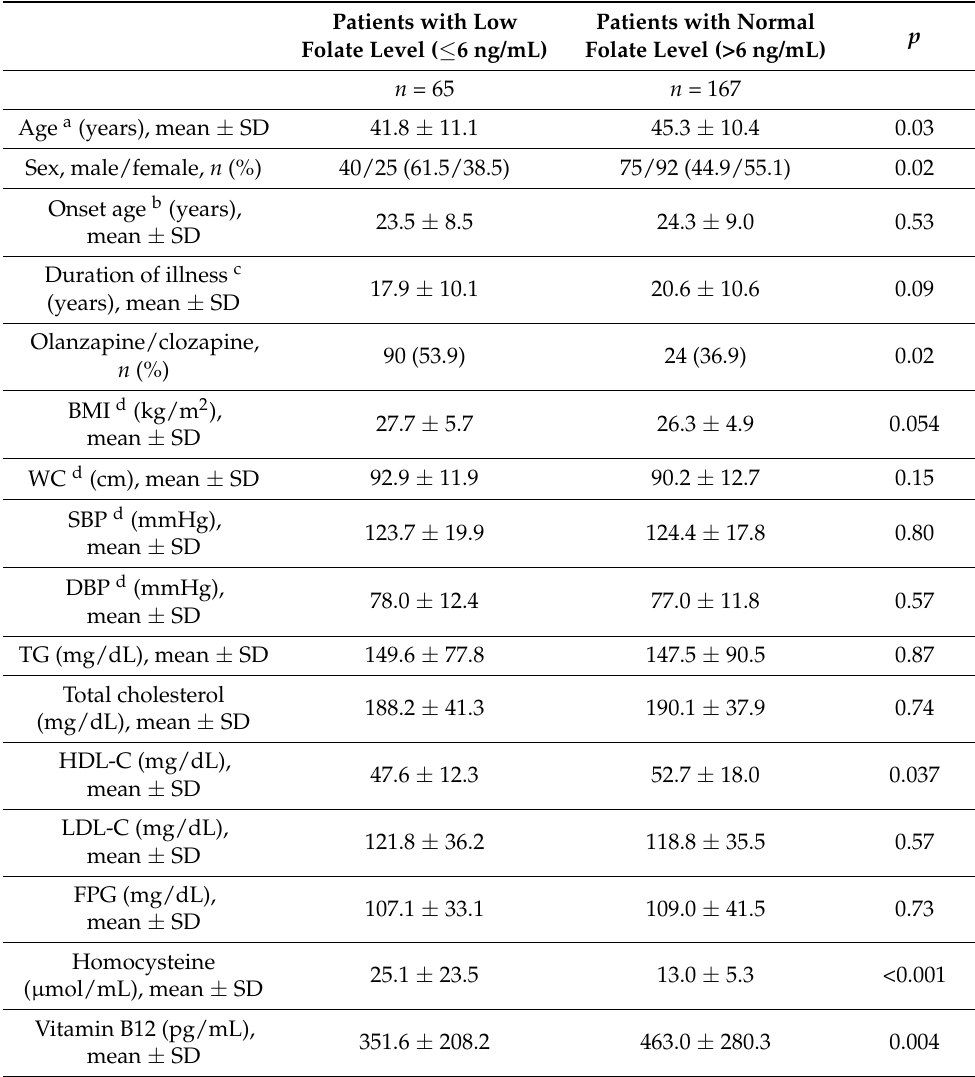
Table 3. Demographics, clinical characteristics, and metabolic parameters of patients with low folate level and those with normal folate